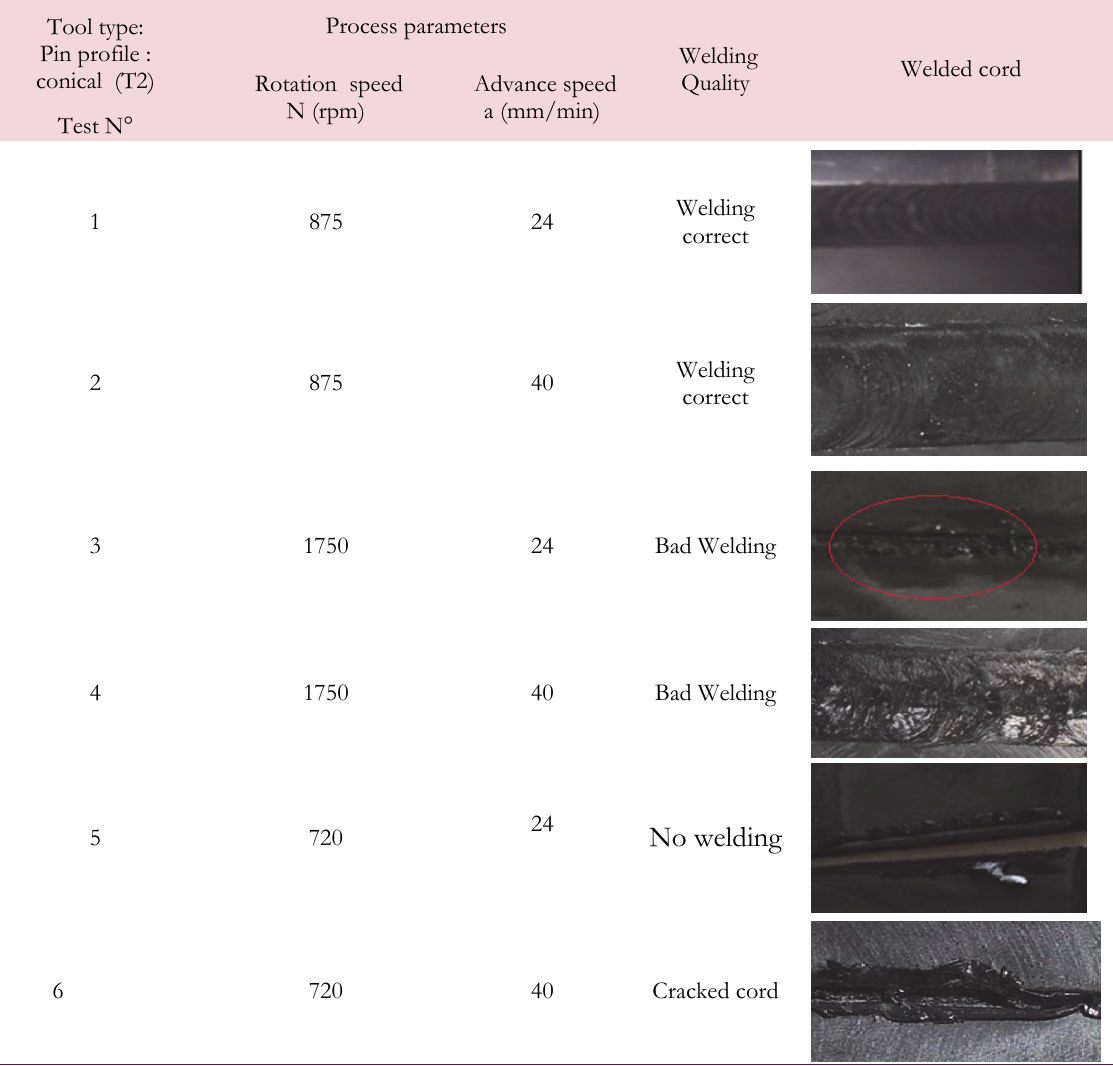
Table 3b: Welding process